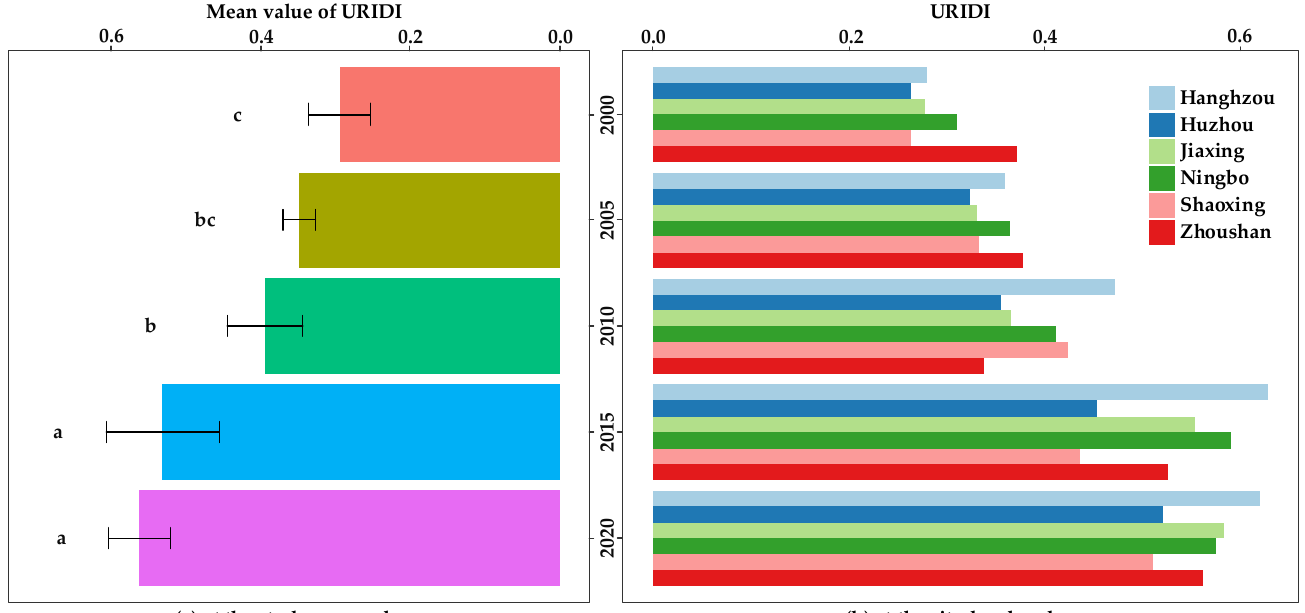
Figure 6. Temporal characteristics of URID level at study-area scale ( a ) and city-level scale ( b ). In ( a ), the same lowercase letter indicates that the URIDI has no significant difference between different years ( p > 0.05) and different lowercase letters indicate that the URIDI has a significant difference between different years ( p < 0.05). The error bars represent the standard deviation.